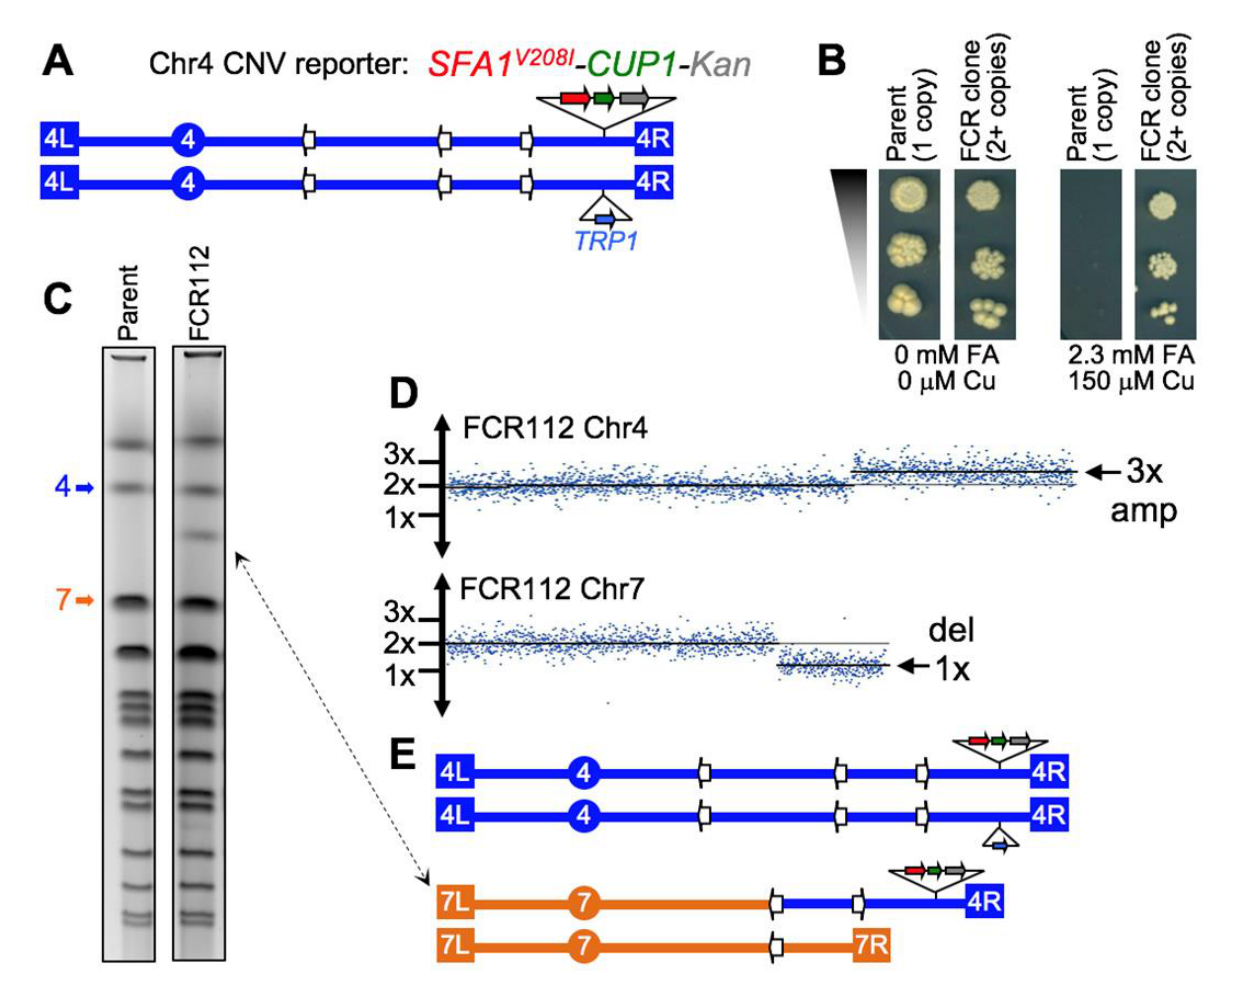
FIGURE 7: The diploid CNV assay. (A) Schematic map of Chr4 in a diploid test strain, showing telomeres (terminal boxes), centromere (circle), and Ty retrotransposon repeats (white arrows). One homolog has an insertion of the CNV reporter near the right end, the other has TRP1 at the allelic position. (B) Reporter dosage-dependent phenotype. Cultures were serially diluted and spotted on plates. The parent strain is una- ble to form colonies on selective media (Copper [Cu] and Formaldehyde [FA]), while an FCR clone displays full viability. (C) Pulse field karyo- types showing a ~1.3 Mb chromosomal rearrangement in CNV clone FCR112 (double-end arrow). The bands corresponding to normal Chr4 and Chr7 are indicated. (D) array-CGH data for FCR112. The plots show a 3x copy number amplification region on the right arm of Chr4, and a 1x deletion on the right arm of Chr7. The copy number breakpoints in both chromosomes correspond to the positions of Ty dispersed repeats. (E) Karyotype prediction for FCR112, showing a Chr7/Chr4 non-reciprocal translocation with a breakpoint junction at Ty sequences, suggesting a non-allelic homologous recombination mechanism of formation. Data credit to Ane Zeidler; full results to be described elsewhere (Zeidler, Argueso, et al. , in preparation OPEN ACCESS | www.microbialcell.com 19 Microbial Cell | JANUARY 2019 | Vol. 6 No. 1